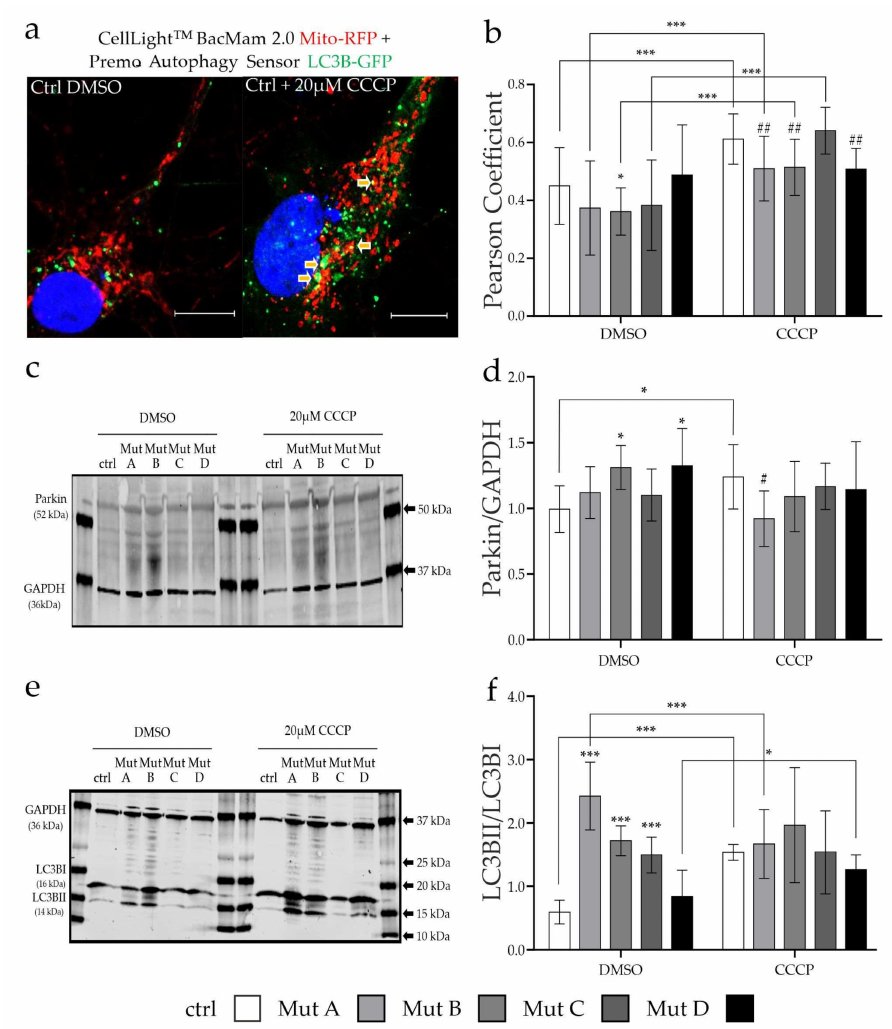
Figure 4. Analysis of the induction of mitophagy with CCCP. ( a ) Example cells transduced with CellLight TM BacMam 2.0 MitoRFP and LC3B-GFP of the control cell line, without treatment (DMSO) and with treatment with carbonyl cyanide chlorophenylhydrazone (CCCP). Arrows indicate au- tophagosomes with enclosed mitochondria. Scalebar = 20 µ m. ( b ) Analysis of colocalization of mitochondria and autophagosomes was performed on the pictures shown in ( a ). The three NPC1- deficient cell lines tended to show a reduced colocalization, but only one was significantly reduced. After CCCP treatment, the reduction was even more pronounced. N = 3, n = 30. ( c ) Parkin (52 kDa) expression was determined by Western blot. ( d ) An increased parkin level could be detected in Mut B and Mut D. After CCCP treatment, almost all NP-C cell lines showed a reduced parkin level compared to the control cell line. N = 4, n = 7–11. ( e ) Example Western blot of LC3B with the two isoforms LC3BI (16 kDa) and LC3BII (14kDa). ( f ) Quantification of Western blot shown in ( e ). All three NPC1-deficient cell lines showed an increased LC3BII/LC3BI ratio. After CCCP treatment, no differences between the cell lines could be observed. N = 4, n = 7–12. Graphs show mean ± SD. Two-way ANOVA with Sidak’s multiple comparisons test was used to determine statistical significance. Statistical significance against the untreated control is indicated by (*), with * = p < 0.05, *** = p < 0.001; and against the treated control by (#), with # = p < 0.05, ## = p < 0.01. ctrl = control cell line. Mut A (NP-C1): c.1180T>C; Mut B (NP-C1): c.1836A>C/c.1628delC; Mut C (NP-C1): c.3182T>C; Mut D (NP-C2):